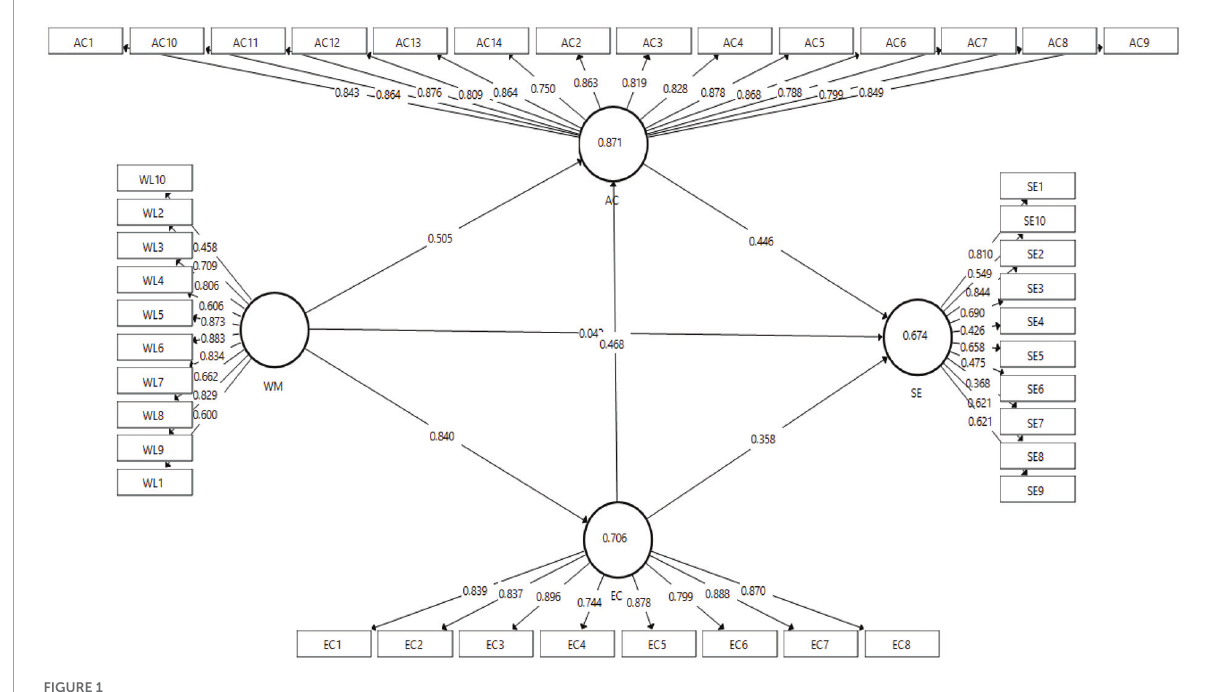
FIGURE1 Structural